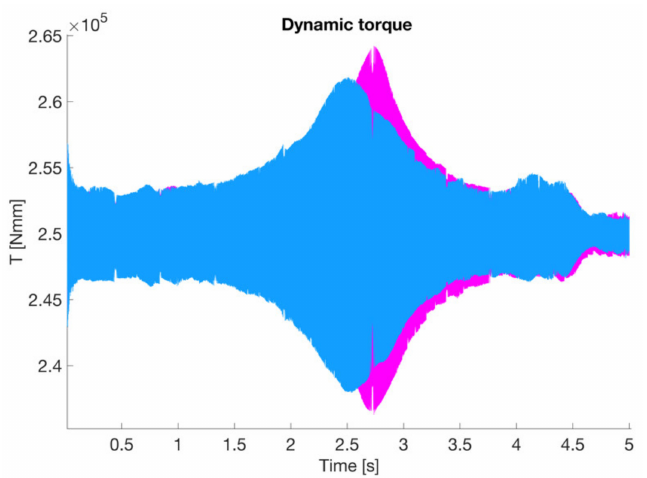
Figure 7. Dynamic variation in the torque for the two different geometries (blue—solid web, purple—flexible